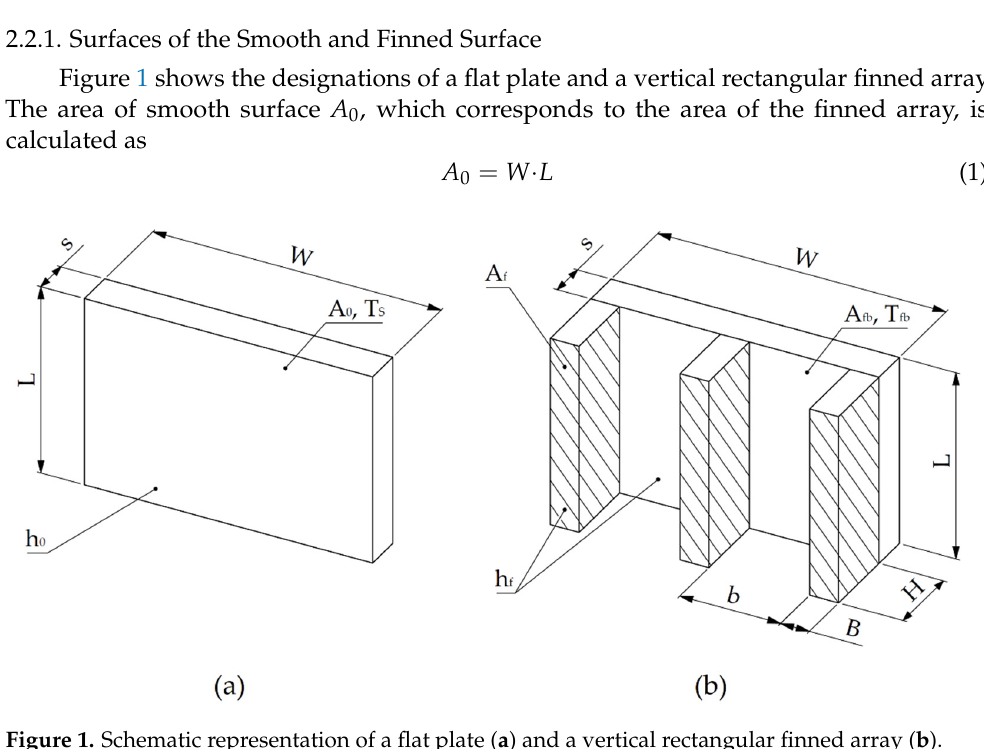
Figure 1. Schematic representation of a flat plate ( a ) and a vertical rectangular finned array ( b ). Concerning the finned array, the perimeter P f , the cross-sectional area A f , cs , the surface area A f , s , total fin area A f, and the fin base area A fb are calculated using the formulas below. The end surfaces of the fin or the finned array are neglected.